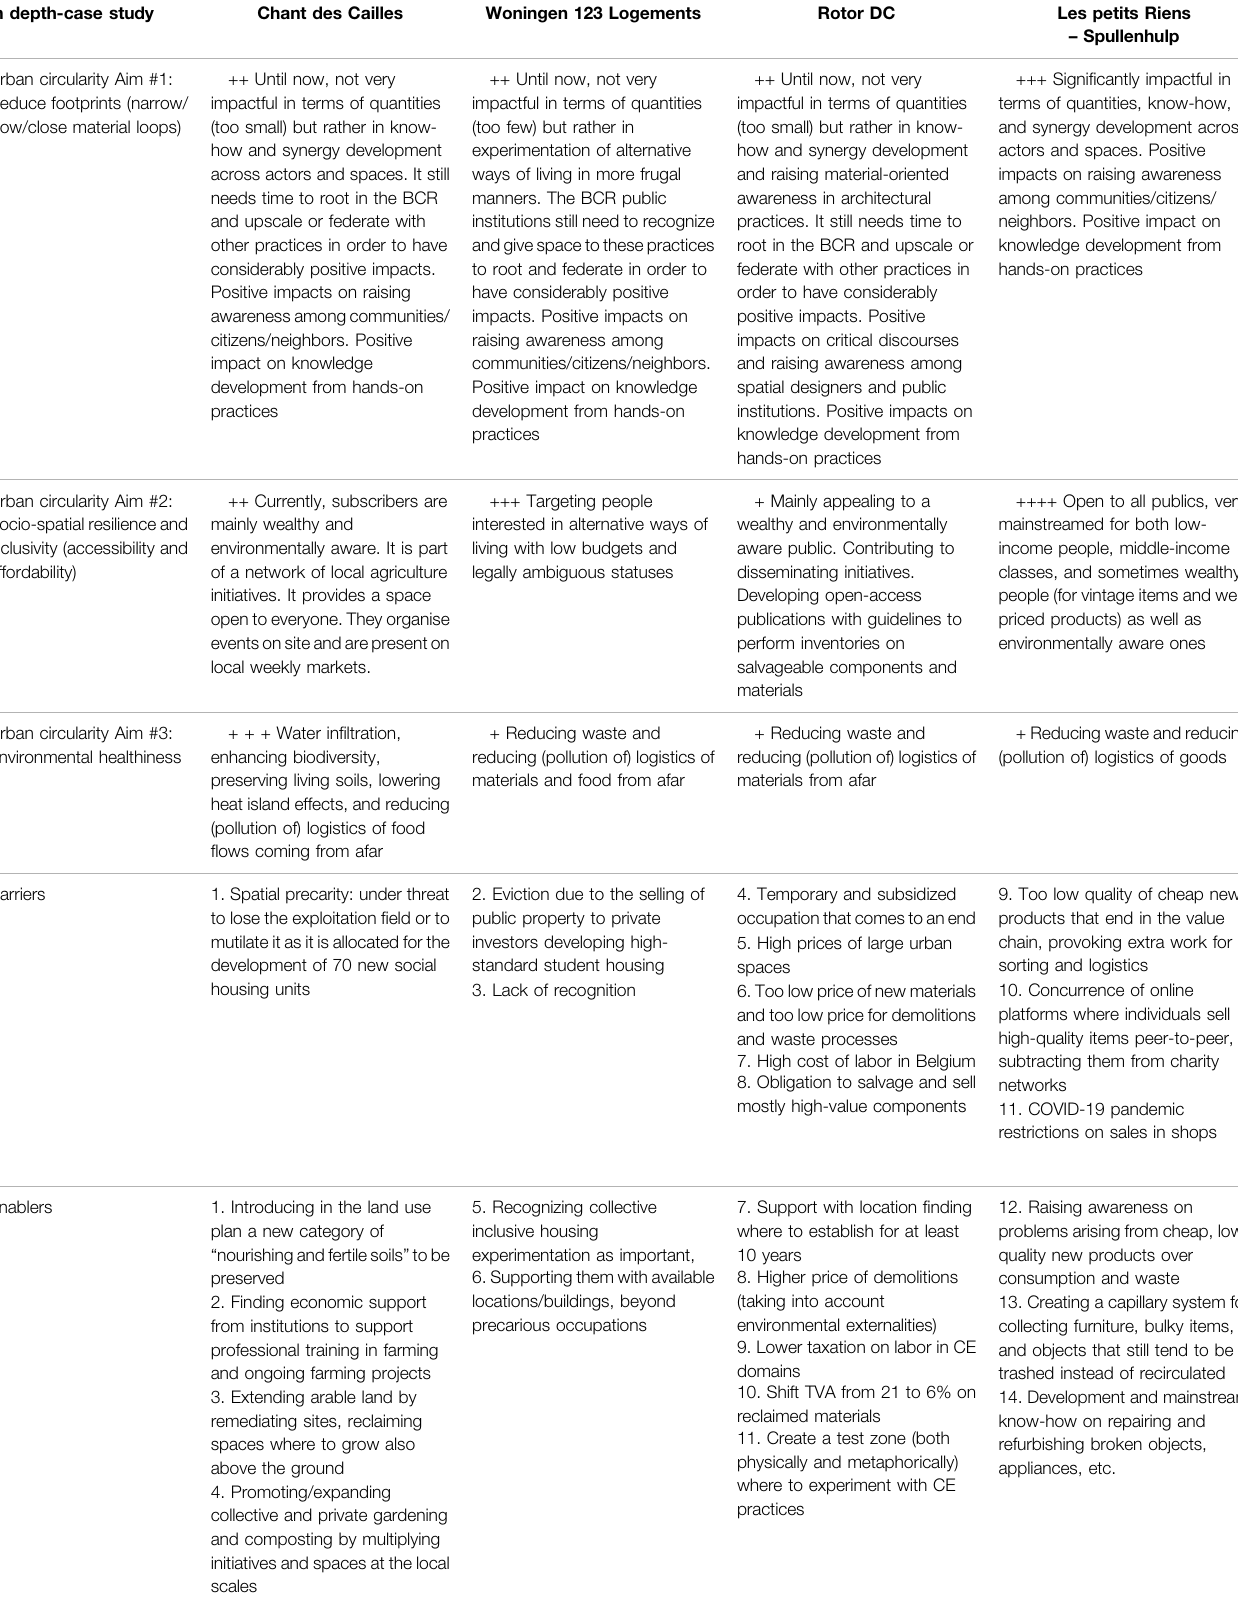
TABLE 6 | Comparative analysis of the four in-depth case studies following the research framework (spaces, fl ows, and actors), by the authors. In depth-case study